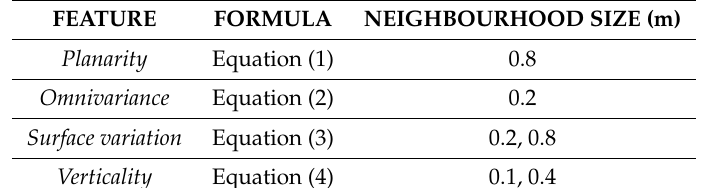
Table 2. Geometric features considered to train the model with their relative neighbourhood size.